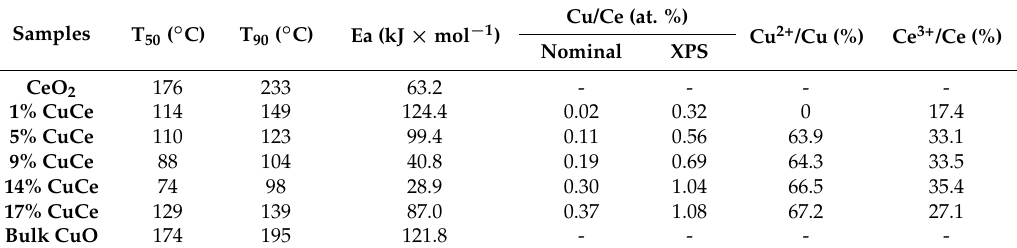
Table 2. Catalytic performance and surface chemical properties of various